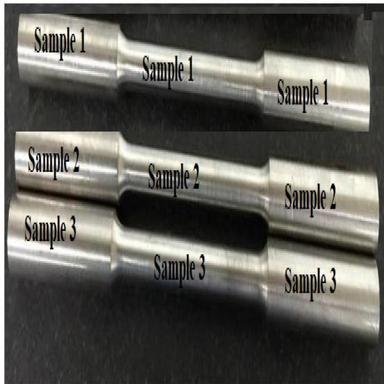
Tensile test conduct on MMNC Samples S1, S2 &S3.